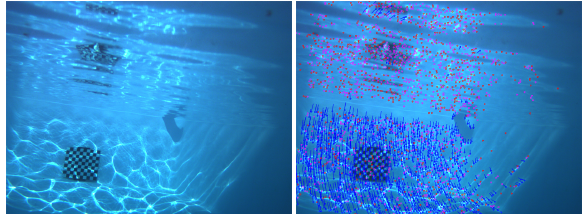
Figure 11. Light spots on the surface of the water (top) seem to have a higher speed than that of caustics (bottom) and cannot be matched with our synchronization delay of 1